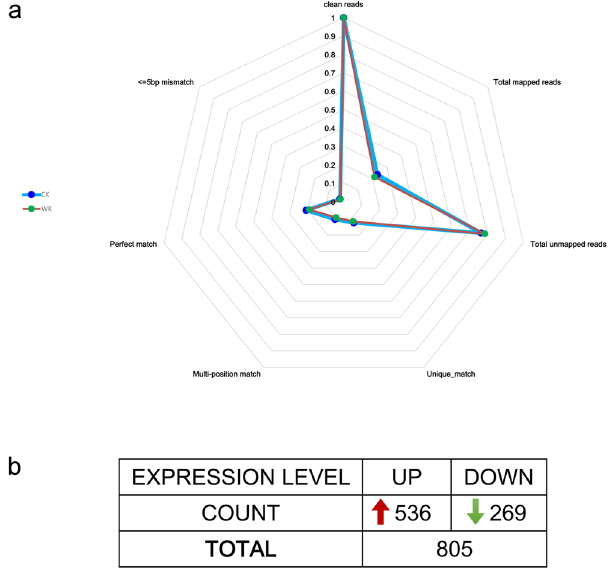
Figure 1. The results of transcriptome sequencing analysis under K + stress conditions. ( a ) The comparing results from the mapping procedure of transcriptome sequencing between ck and K + stressed sample; ( b ) The summary of differentially expressed rice genes detected in the transcriptome